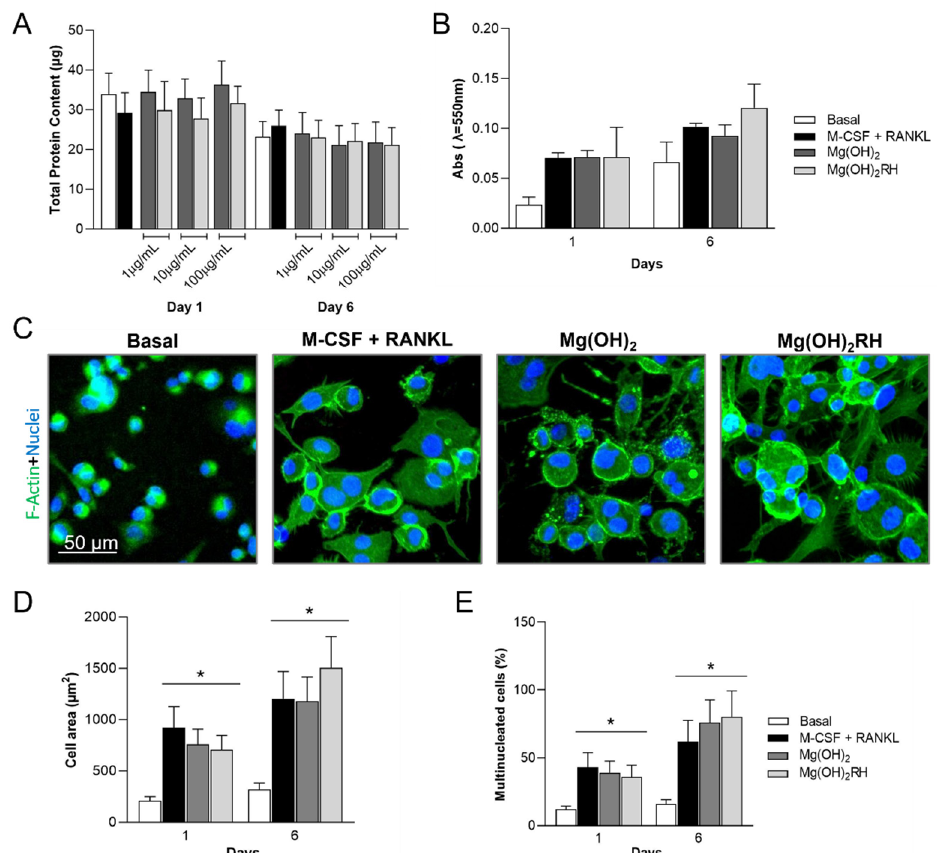
Figure 4. ( A )—total protein content of THP-1-derived cells cultured in basal medium, in the presence of M-CSF and RANKL, and exposed to Mg(OH) 2 and Mg(OH) 2 RH NPs (1, 10 and 100 µg/mL) for 1 and 6 days; ( B )—cell viability (MTT assay) of THP-1 cells cultured in basal medium, in the presence of M-CSF and RANKL, and exposed to Mg(OH) 2 and Mg(OH) 2 RH NPs at 100 µg/mL, for 1 and 6 days. ( C )—immunostaining of F-actin cytoskeleton (green) and nucleus (blue) of cultures grown in basal conditions, in the presence of M-CSF and RANKL, and treated with the NPs (10 µ g/mL) for 1 day; ( D )—cell area; and ( E )—percentage of multinucleated cells. * Significantly different from the cultures grown in basal medium.